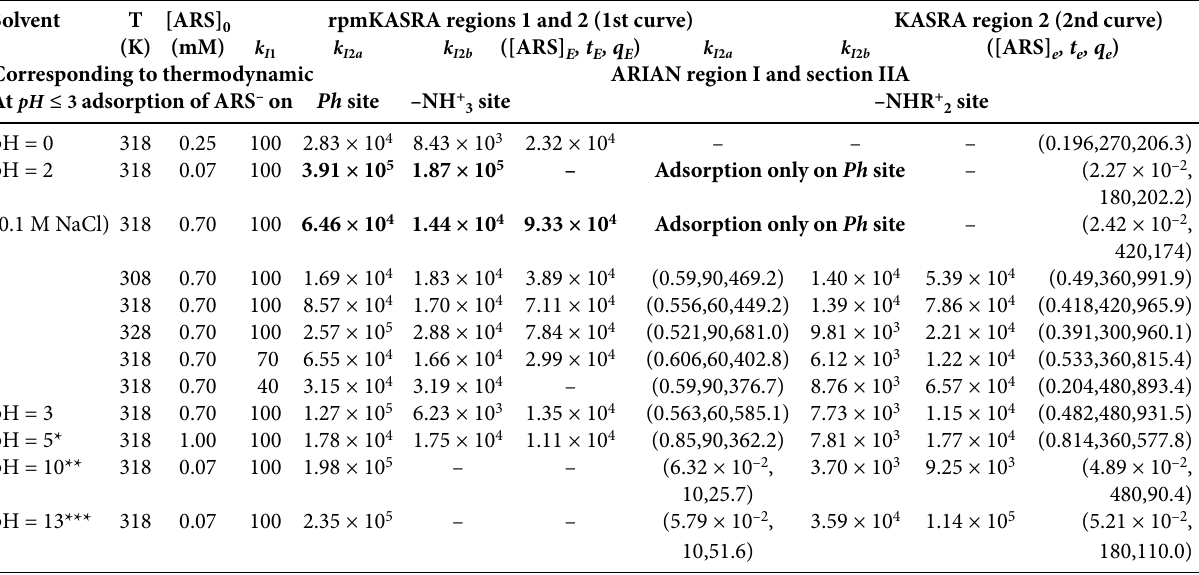
Table 6. Coefficients of region 1 and region 2 (parts 2 a and 2 b ) of the ISO equation for kinetics of ARS adsorption on different sites of GO/ PAMAM at 308–328 K. Solvent T [ARS]